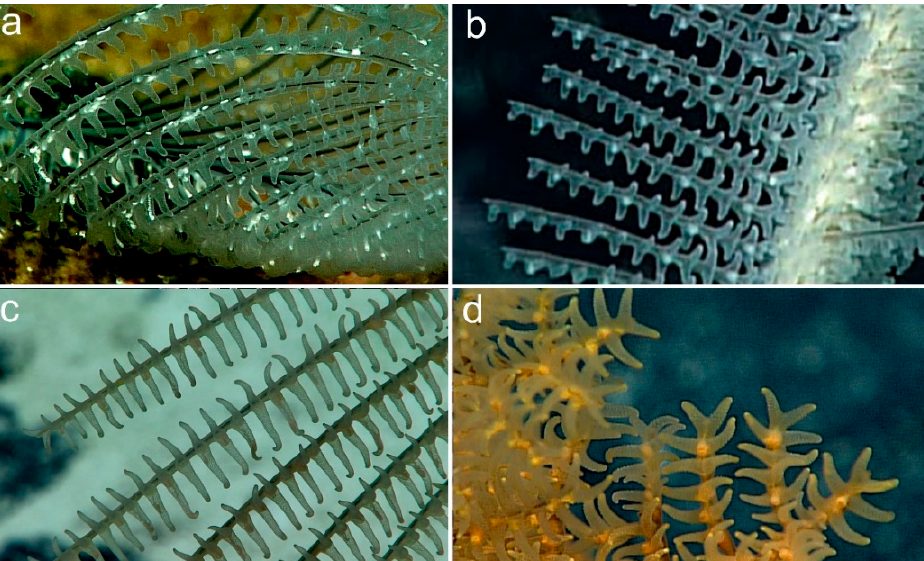
Figure 4. Polyps of Cladopathidae and Schizopathidae: ( a ) Abyssopathes lyra (USNM 1453760); ( b ) Heteropathes pacifica ; ( c ) Bathypathes cf patula Brook, 1889; ( d ) Stauropathes staurocrada Opresko, 2002. In situ photos taken by the ROV Deep Discoverer (NOAA Ship Okeanos Explorer , Cruises EX 1703, EX1708, and EX1504L2). Photos courtesy of the NOAA OER.